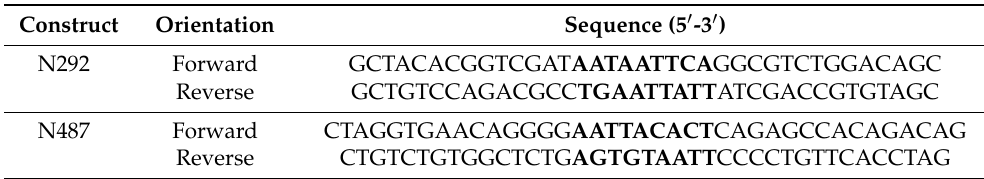
Table 1. Nucleotide sequence of primers used for the site-directed mutagenesis to insert N- glycosylation motifs. Altered/modified sequences are